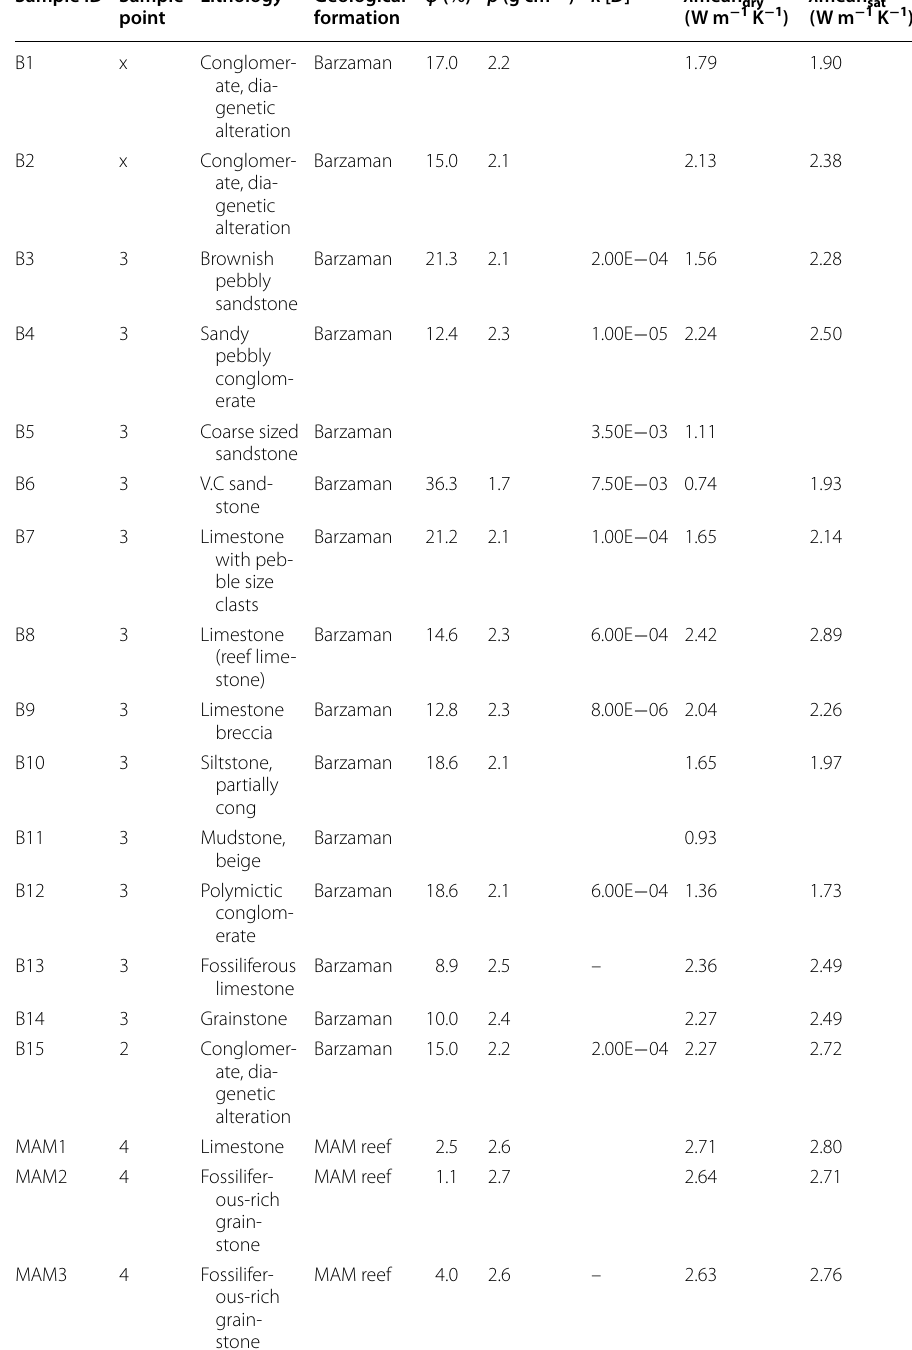
) and water-saturated ( λ mean , W m − 1 K − 1 dry sat